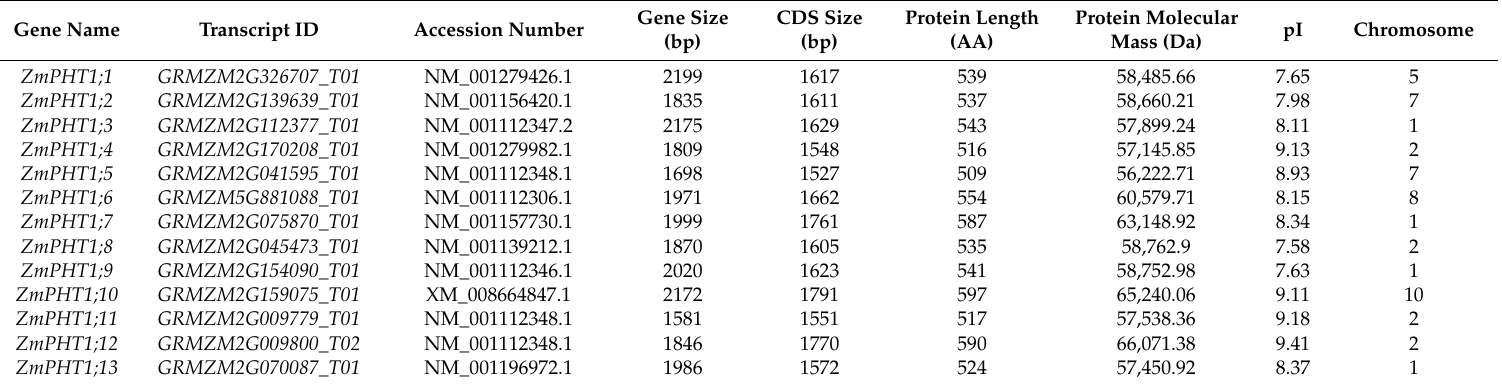
Table 1. Details of the PHT1 genes of